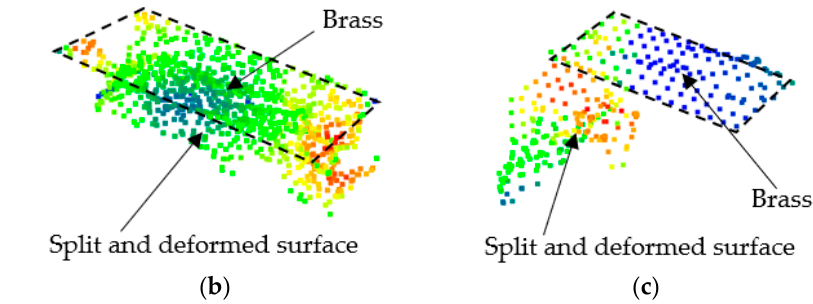
Figure 15. Scans affected by aberrations; scalar field refers to the surface variation value: steel with 2 cm resolution ( a ), brass with 1.5 cm resolution ( b ), brass with 2 cm resolution ( c ).